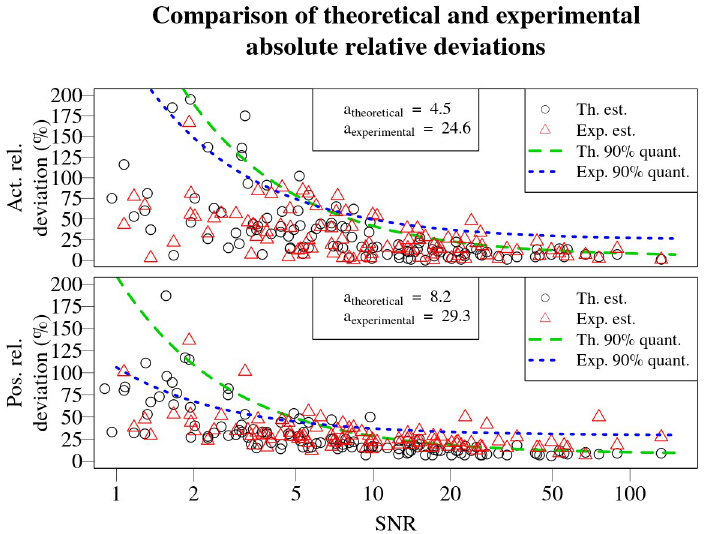
Fig 19. Comparison of the asymptotic values of quantile regression for activity and position relative deviations obtained using theoretical data (from [13]) and experimental data. The asymptotic values a are displayed in the legend in the top. The quantile regression line for theoretical data is marked with green dashed curve, while for the experimental data—blue dotted curve.